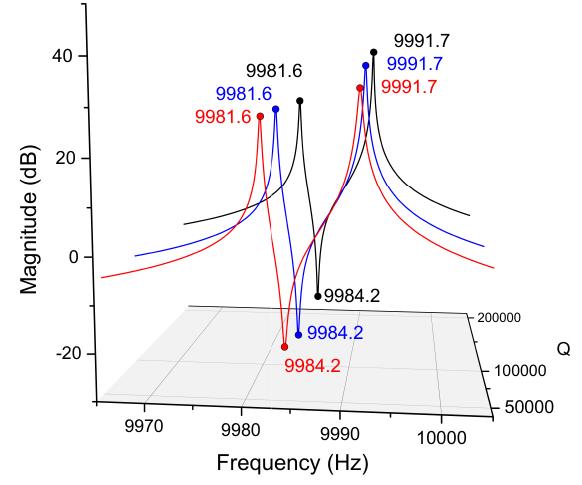
Figure 4. Magnitude-frequency responses of T 11 ( s ,0 ) with different damping